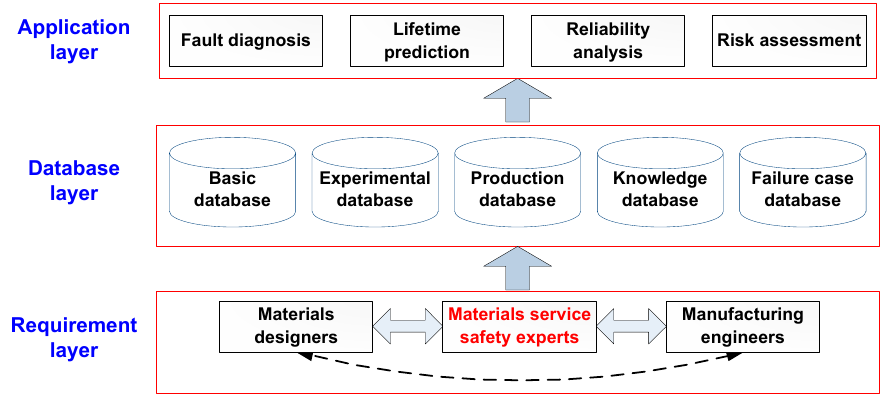
Figure 4. Architecture of a multidiscipline integrated platform for manufacturing engineering processes.